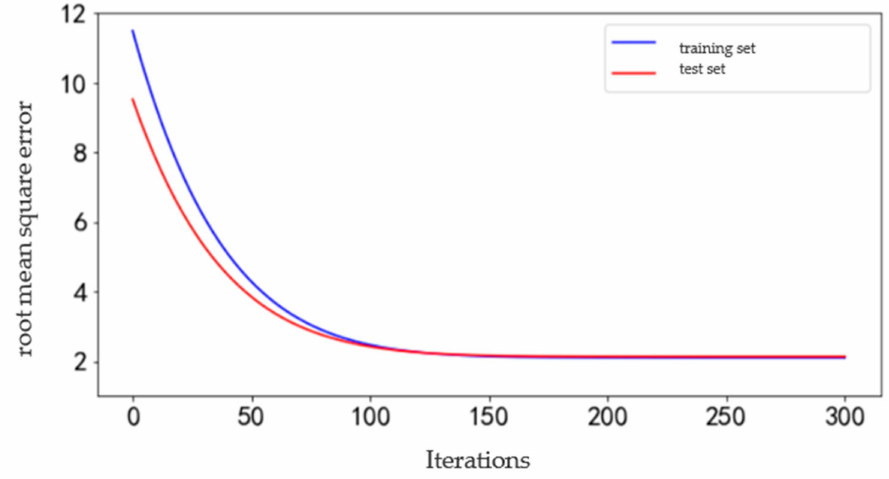
Figure 11. Error training